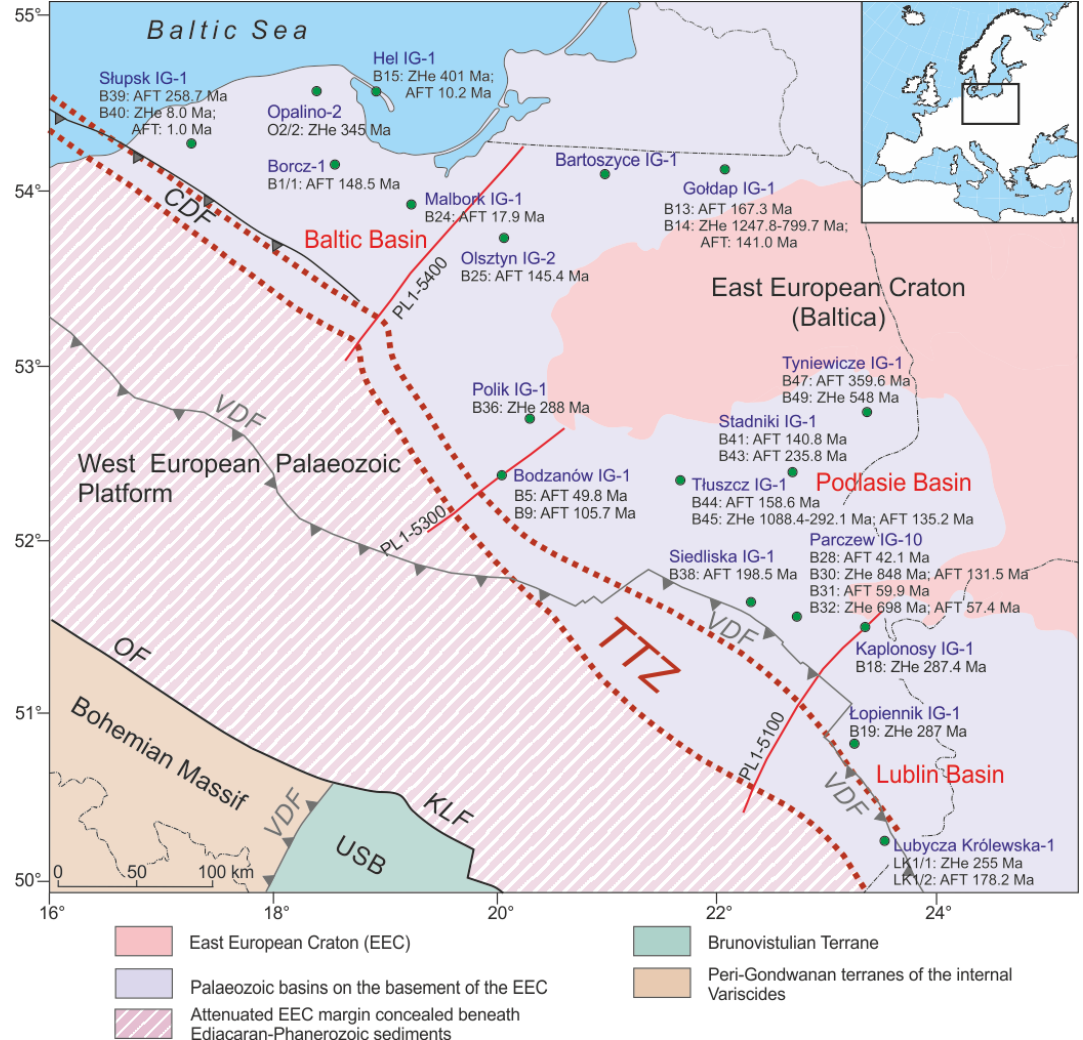
Figure 1. Simplified tectonic map of central and north-eastern Poland (modified from Mazur et al., 2018b) showing the location of borehole samples and the AFT and ZHe ages obtained. The locations of PolandSPAN™ seismic profiles (PL1-5100, 5300, 5400) used in Fig. 2 are indicated. CDF – Caledonian Deformation Front; KLF – Kraków–Lubliniec Fault; OF – Odra Fault; VDF – Variscan Deformation Front; TTZ – Teisseyre–Tornquist Zone; USB – Upper Silesia